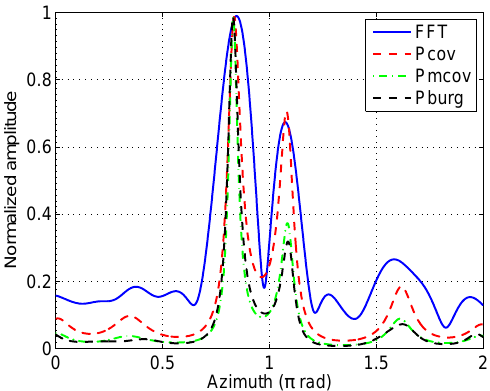
Figure 8. Azimuthal images of two corner reflectors reconstructed by the different methods. FFT: fast Fourier transform method; Pcov: covariance method; Pmcov: Modified covariance method; Pburg: Burg method.